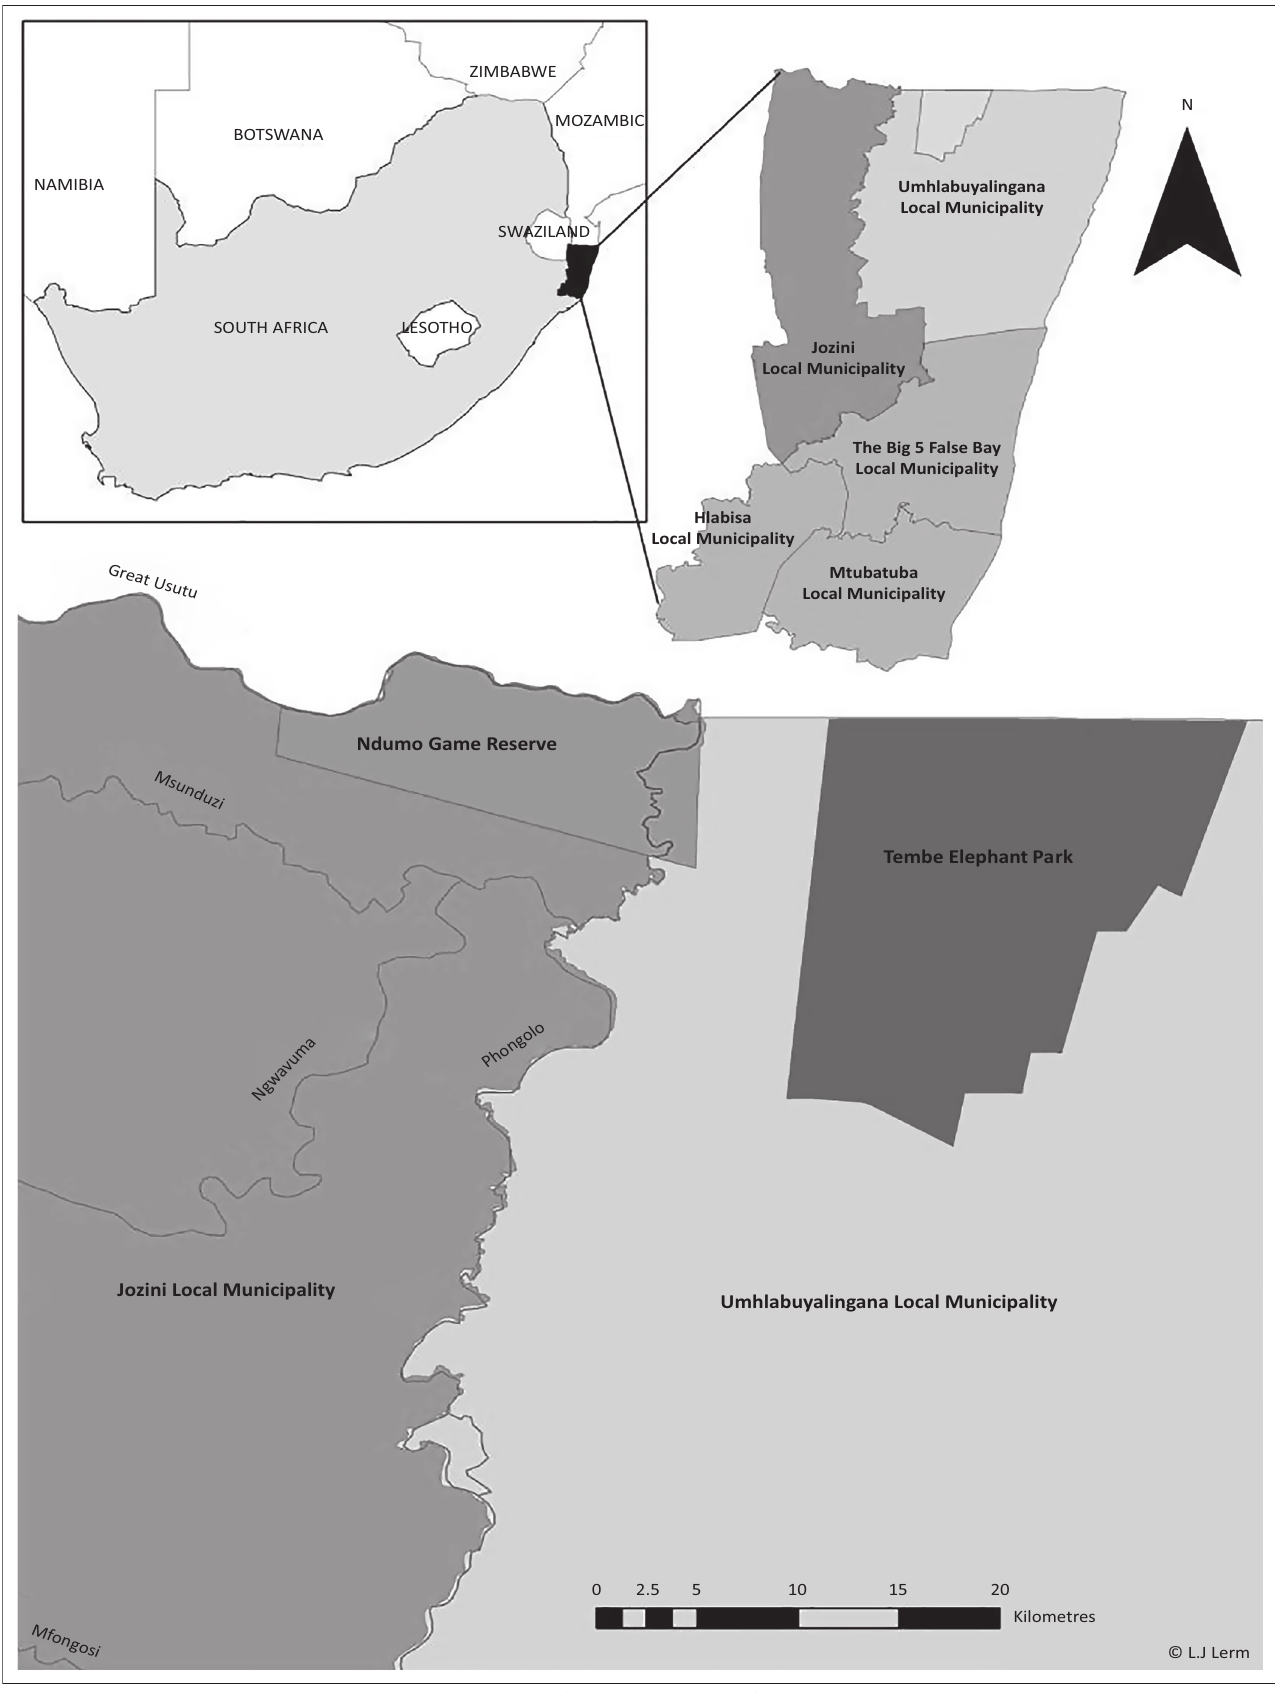
FIGURE 1: Location of the Ndumo area, KwaZulu-Natal, South